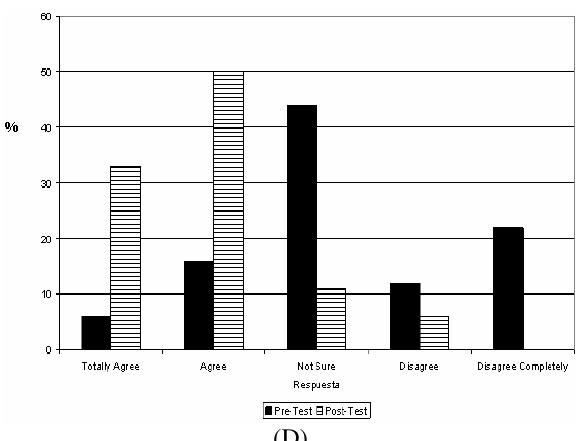
Figure 8: Results of the indoor air quality tool for schools (IAQTFS) training workshop pre and post